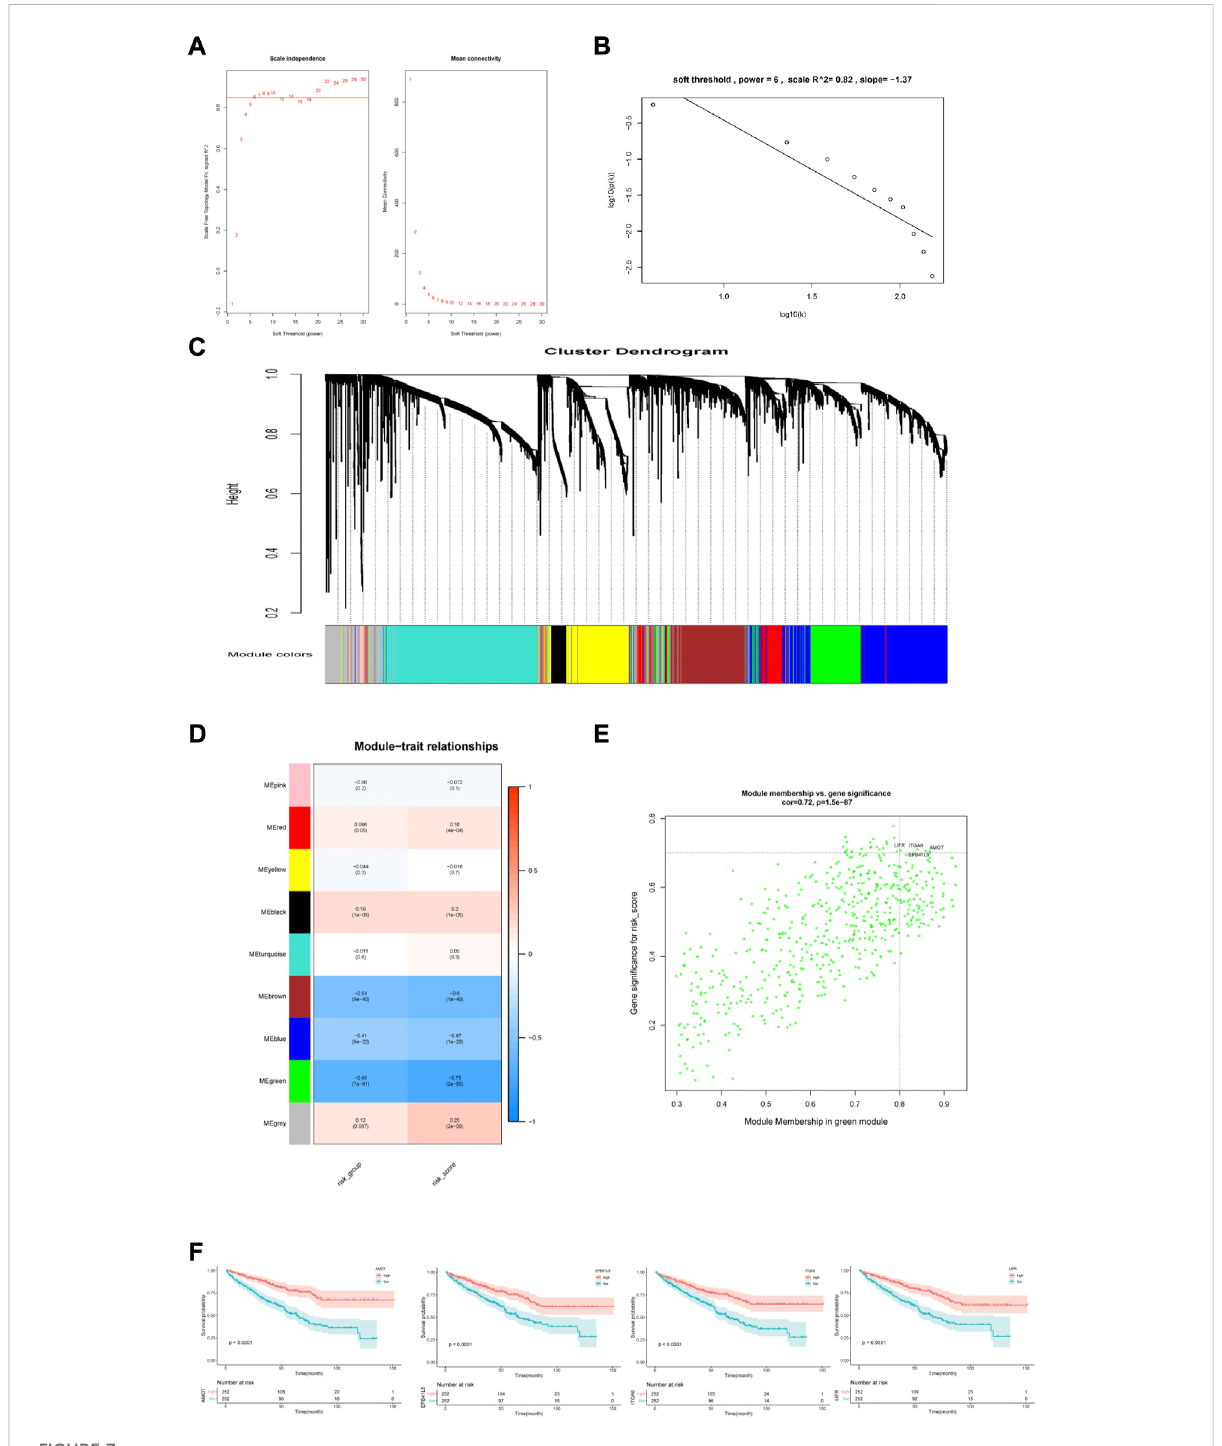
FIGURE 7 Construction and analysisof weighted genecorrelation network. (A,B) Soft threshold fi ltering and validation. (C) The cluster dendrogram of genes. (D) The relationship between 9 module and the risk model. (E) Identi fi cation of the hub genes (|MM| > 0.8, |GS| > 0.7). (F) KM analysis for 4 hub genes.